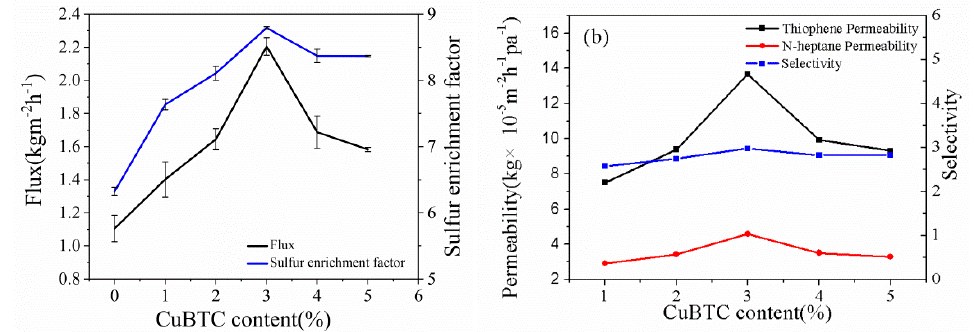
Figure 7. Effect of CuBTC content on ( a ) flux and sulfur enrichment factor; ( b ) permeability and selectivity of the CuBTC-filled PEG MMMs.